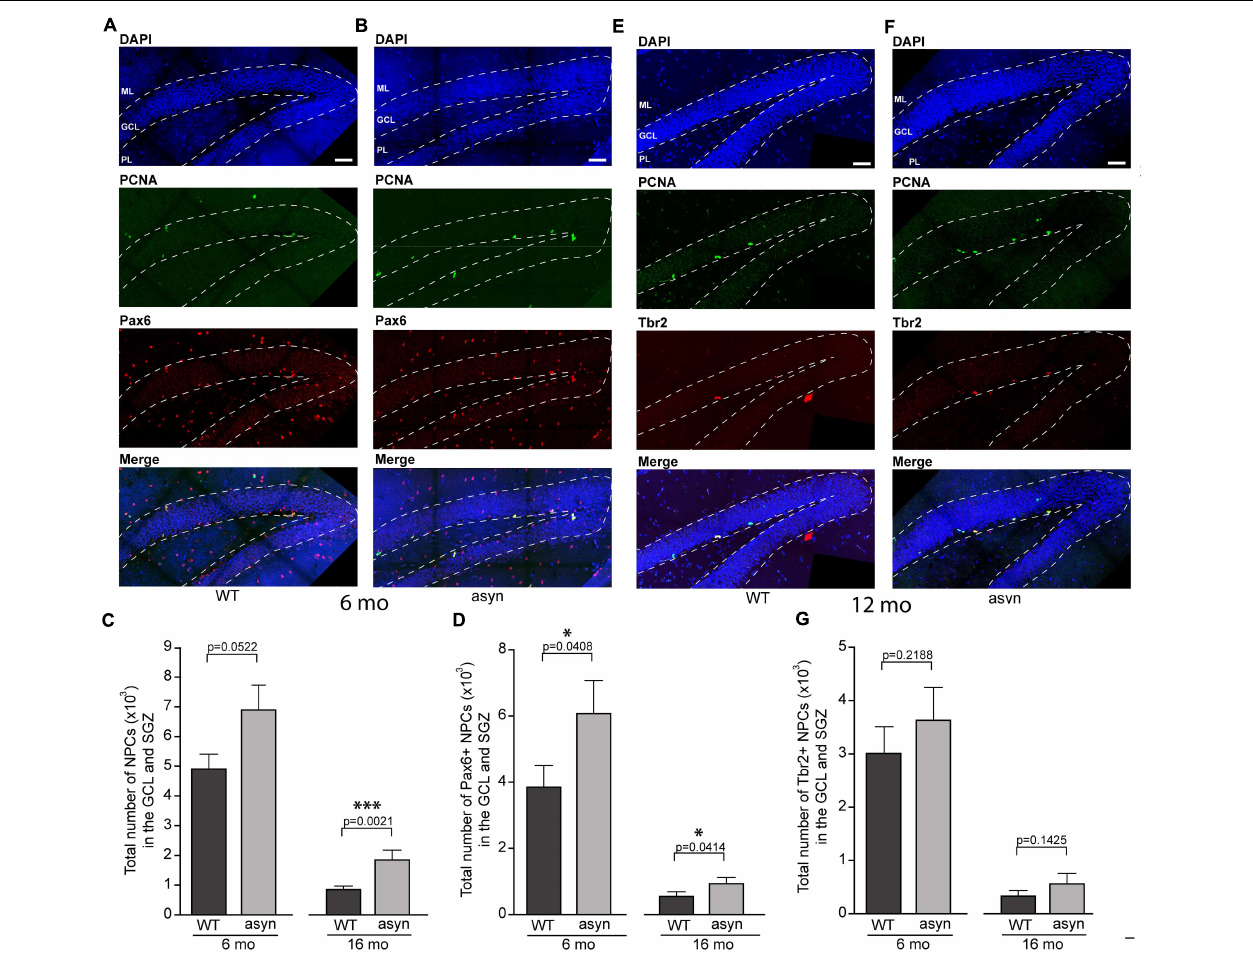
FIGURE 2 | Quantification of PCNA, Pax6 and Tbr2 positive cells in the hippocampal dentate gyrus of wildtype and Thy1-aSyn mice. Double-immunofluorescence for PCNA (green) and Pax6 (red) and DAPI staining (blue) and merged images of 6-month-old wildtype [WT, (A) ] and Thy1-aSyn [asyn, (B) ] mice. Number of PCNA+ cells (C) , Pax6+/PCNA+ cells (D) in the granule cell layer (GCL) and subgranular zone (SGZ) of 6- and 16-month (mo)-old wildtype (WT) and Thy1-aSyn (asyn) mice. Double-immunofluorescence for PCNA (green) and Tbr2 (red) and DAPI staining (blue) and merged image of 6-month-old wildtype [WT, (E) ] and Thy1-aSyn [asyn, (F) ] mice. Number of Tbr2 + /PCNA + cells (G) in the GCL and SGZ of 6 and 16 month-old (WT) and Thy1-aSyn (asyn) mice. Data represent mean ± SEM. (WT; 6 month-old, n = 6, 16 month-old n = 6; asyn, 6 month-old, n = 6, 16 month-old n = 5; Student’s t -test; ∗ p < 0.05, ∗∗∗ p < 0.005). GCL, granule cell layer; ML, molecular layer; SGZ, subgranular zone; PL, polymorphic layer. Scale bars, 50 µ